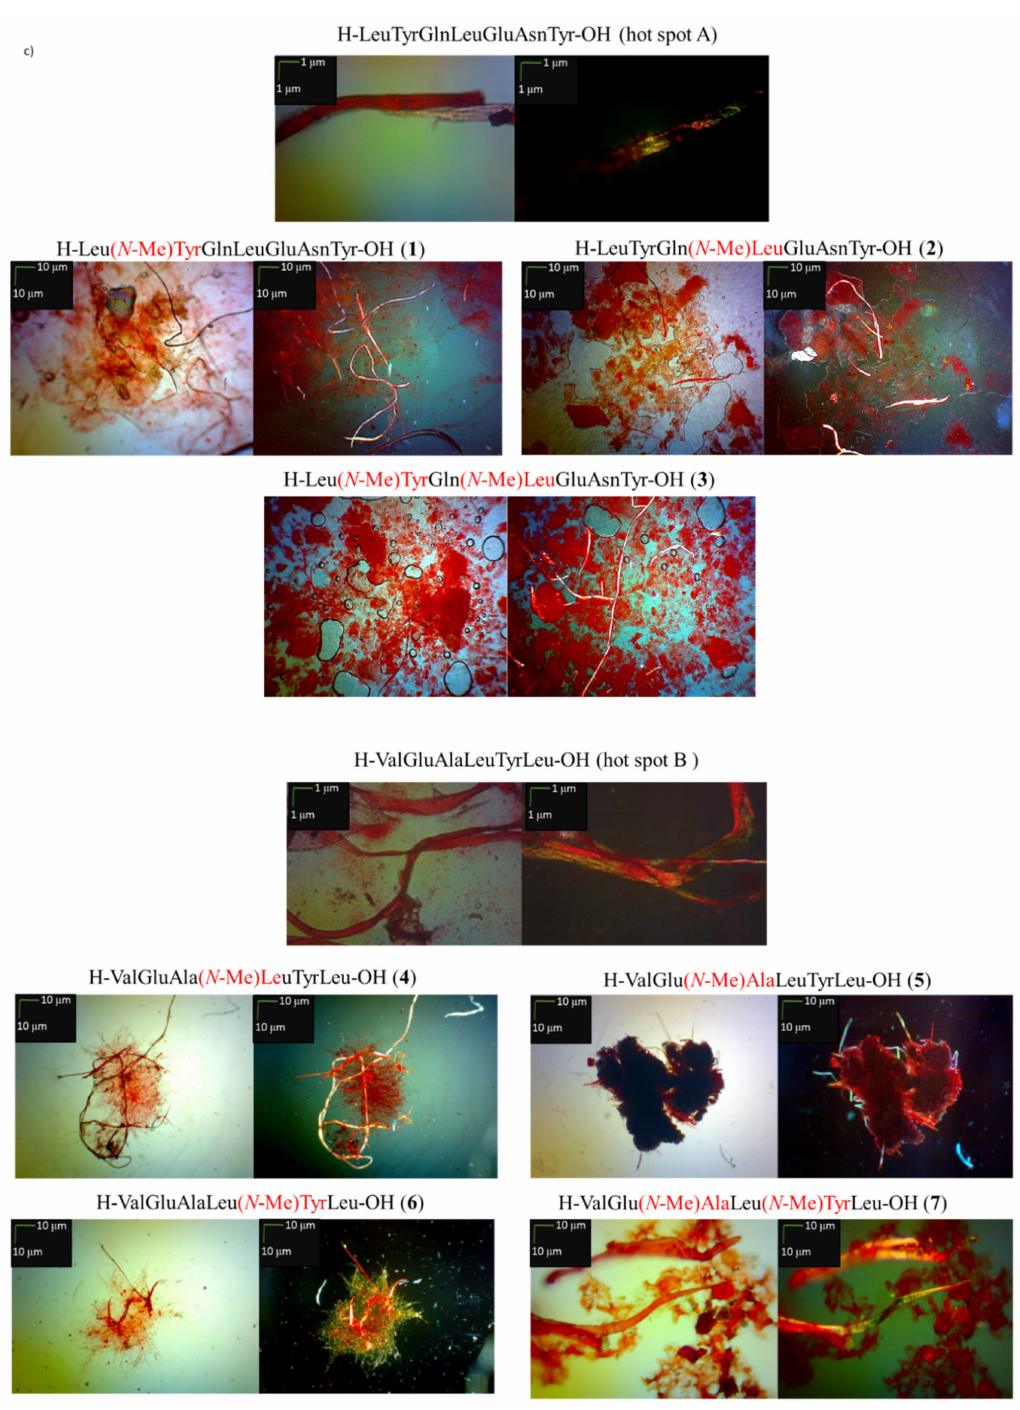
Figure 1. ( a ) Ultraviolet (UV) spectra of peptides 1 – 7 incubated with Congo Red (CR). Results derived after the fourth day of incubation; ( b ) fluorescence intensity spectra of peptides 1 – 7 in the presence of Thioflavin T (ThT), wavelength = 485 nm, after fourth day of incubation; ( c ) pictures of 1 – 7 obtained without a polarized filter (left side) and with a polarized filter (right side). Scale bars, 10 µ m. Microscopic measurements have been performed on the fourth day of